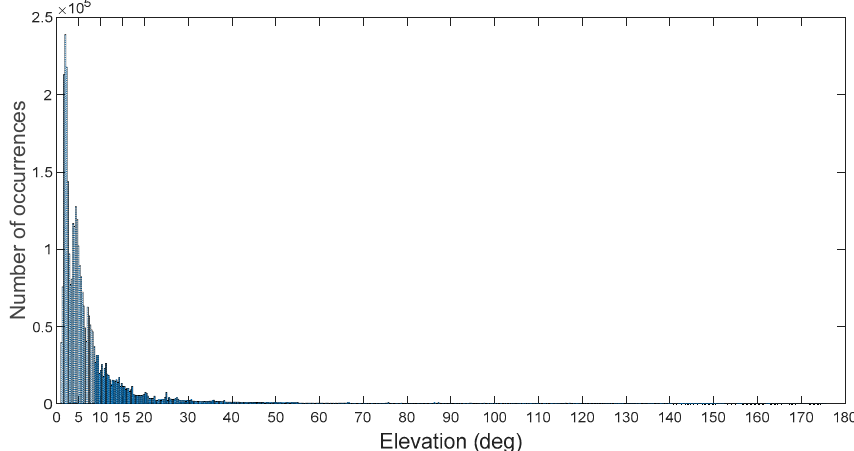
Figure 34. PRNs available for each receiver’s antenna elevation for each altitude of the whole considered MTO.